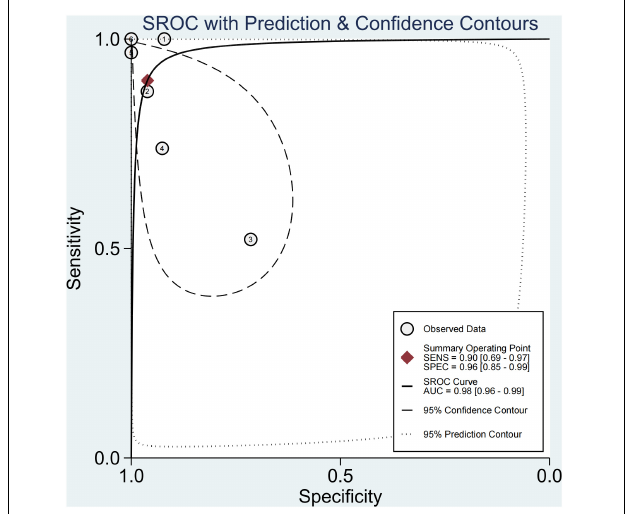
FIGURE 6 | Summary ROC curve of diagnostic performance of elastography for any fibrosis.